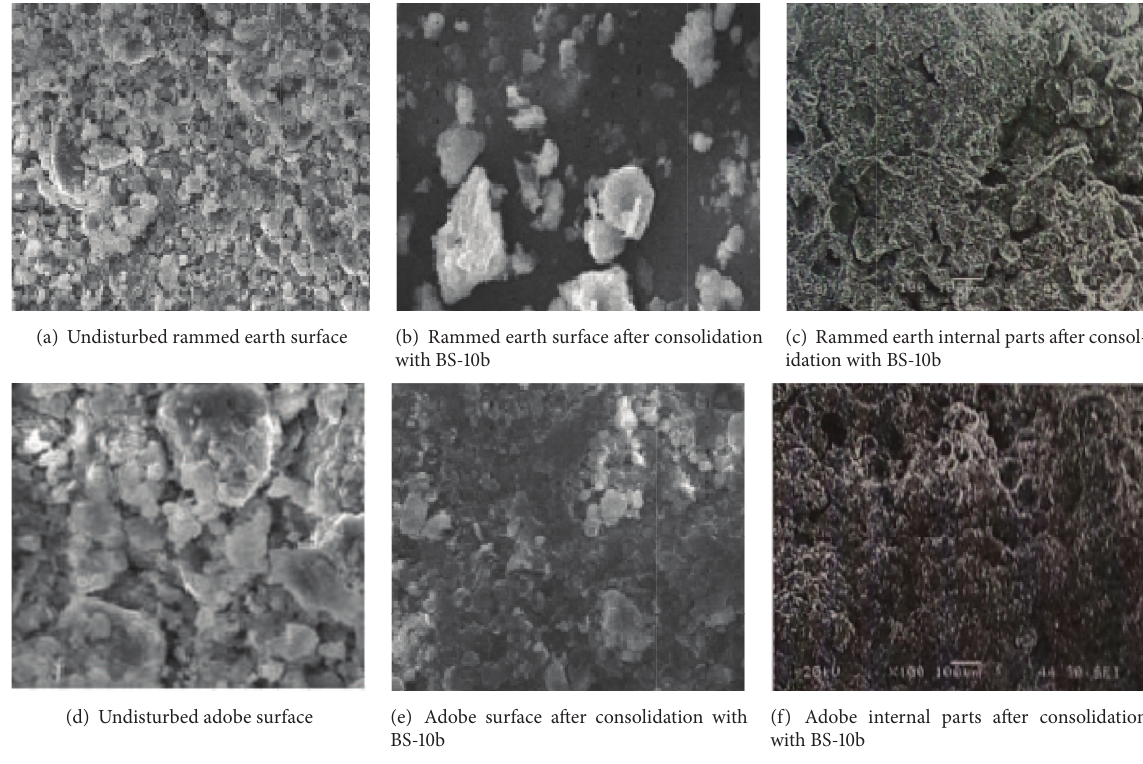
Figure 8: SEM analysis